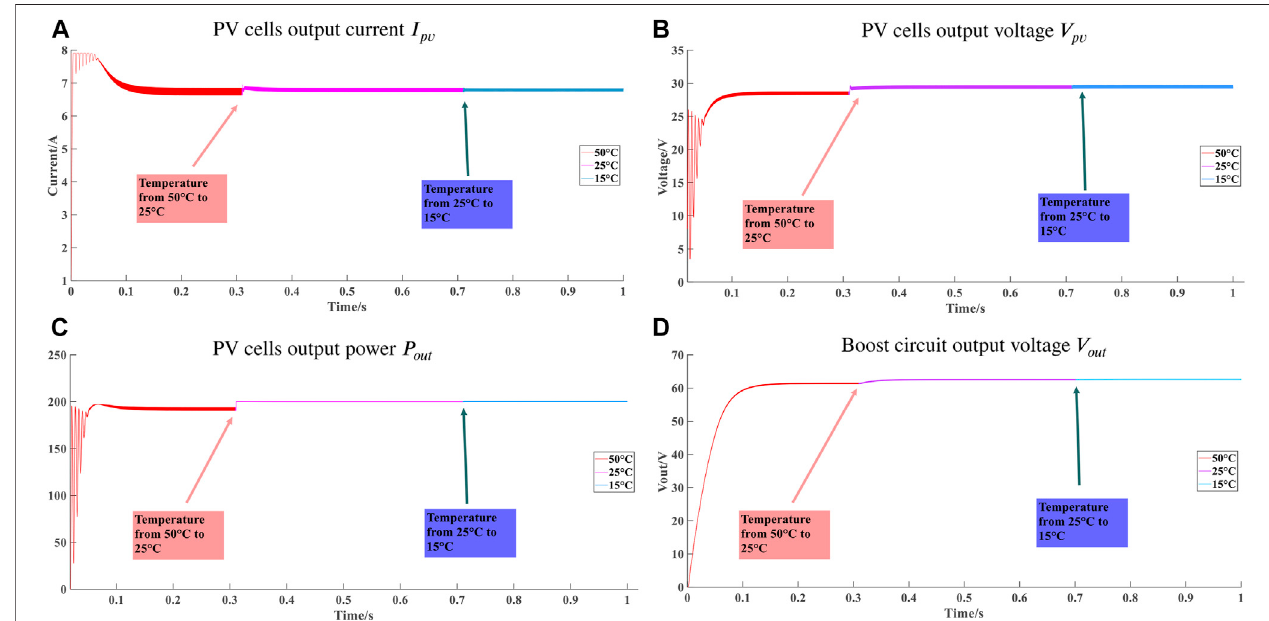
FIGURE7 | The output waveform ofPV cellswhen thetemperature changes\enleadertwodots. (A) PVcells outputcurrent Ipv. (B) PVcells outputvoltage Vpv. (C) PV cells output power Pout. (D) Boost circuit output voltage Vout.